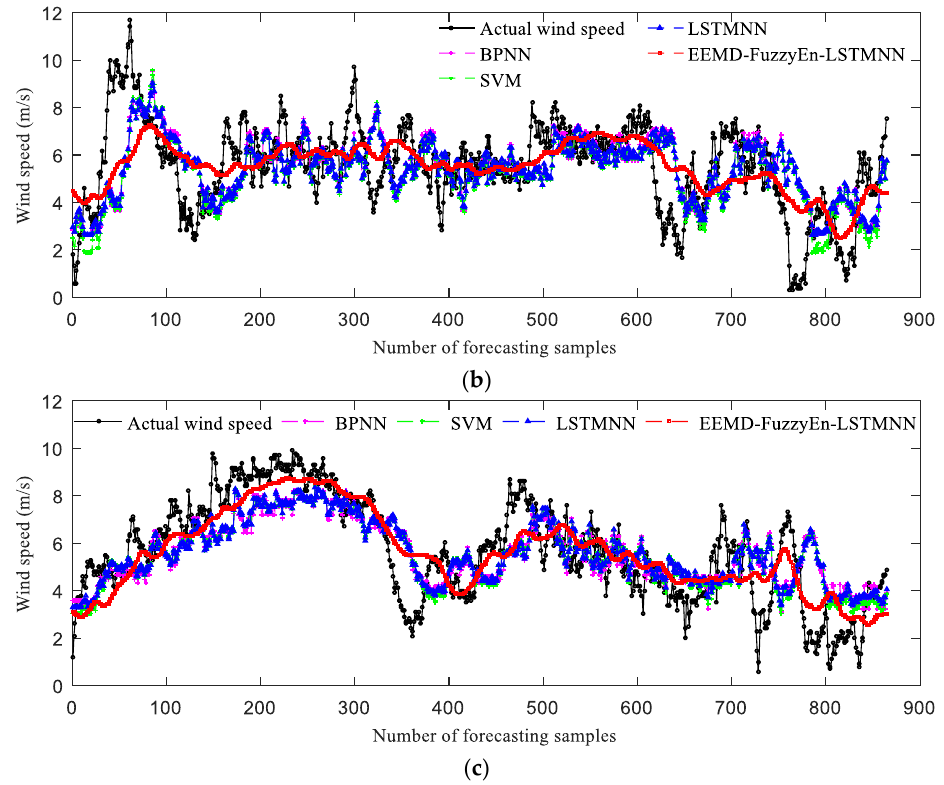
Figure 8. Forecasting results of wind speed series: ( a ) Case A; ( b ) Case B; ( c ) Case C.